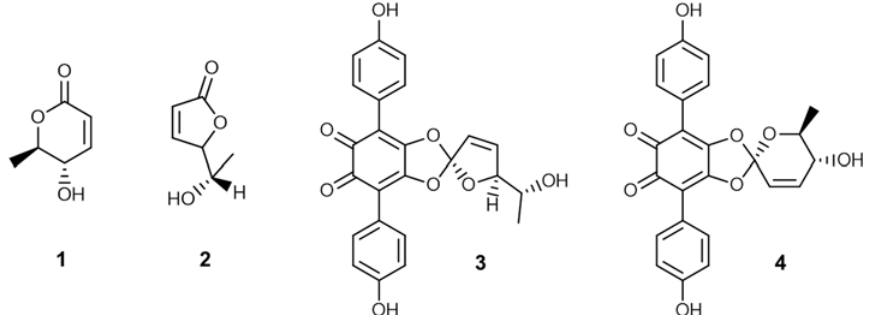
Figure 1. Structures of compounds 1 – 4 isolated from T. atrotomentosa.